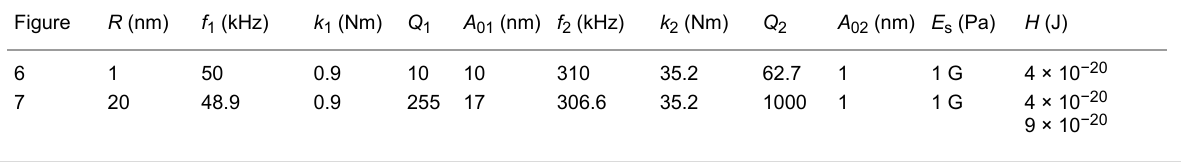
Table 4: Summary of the parameters used in the numerical simulations of bimodal AFM described in Figure 6 and Figure 7. Figure